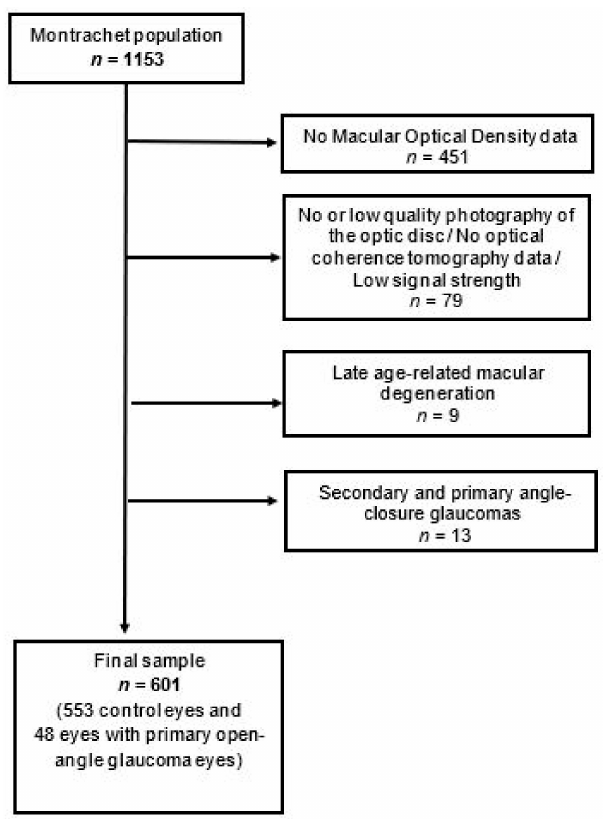
Figure 1. Eyes (553 eyes without optic neuropathy and 48 eyes with POAG). The baseline demo- graphics and clinical characteristics of participants and non-participants are shown in Table 1. Table 1. Baseline characteristics between participants and non-participants in the Montrachet